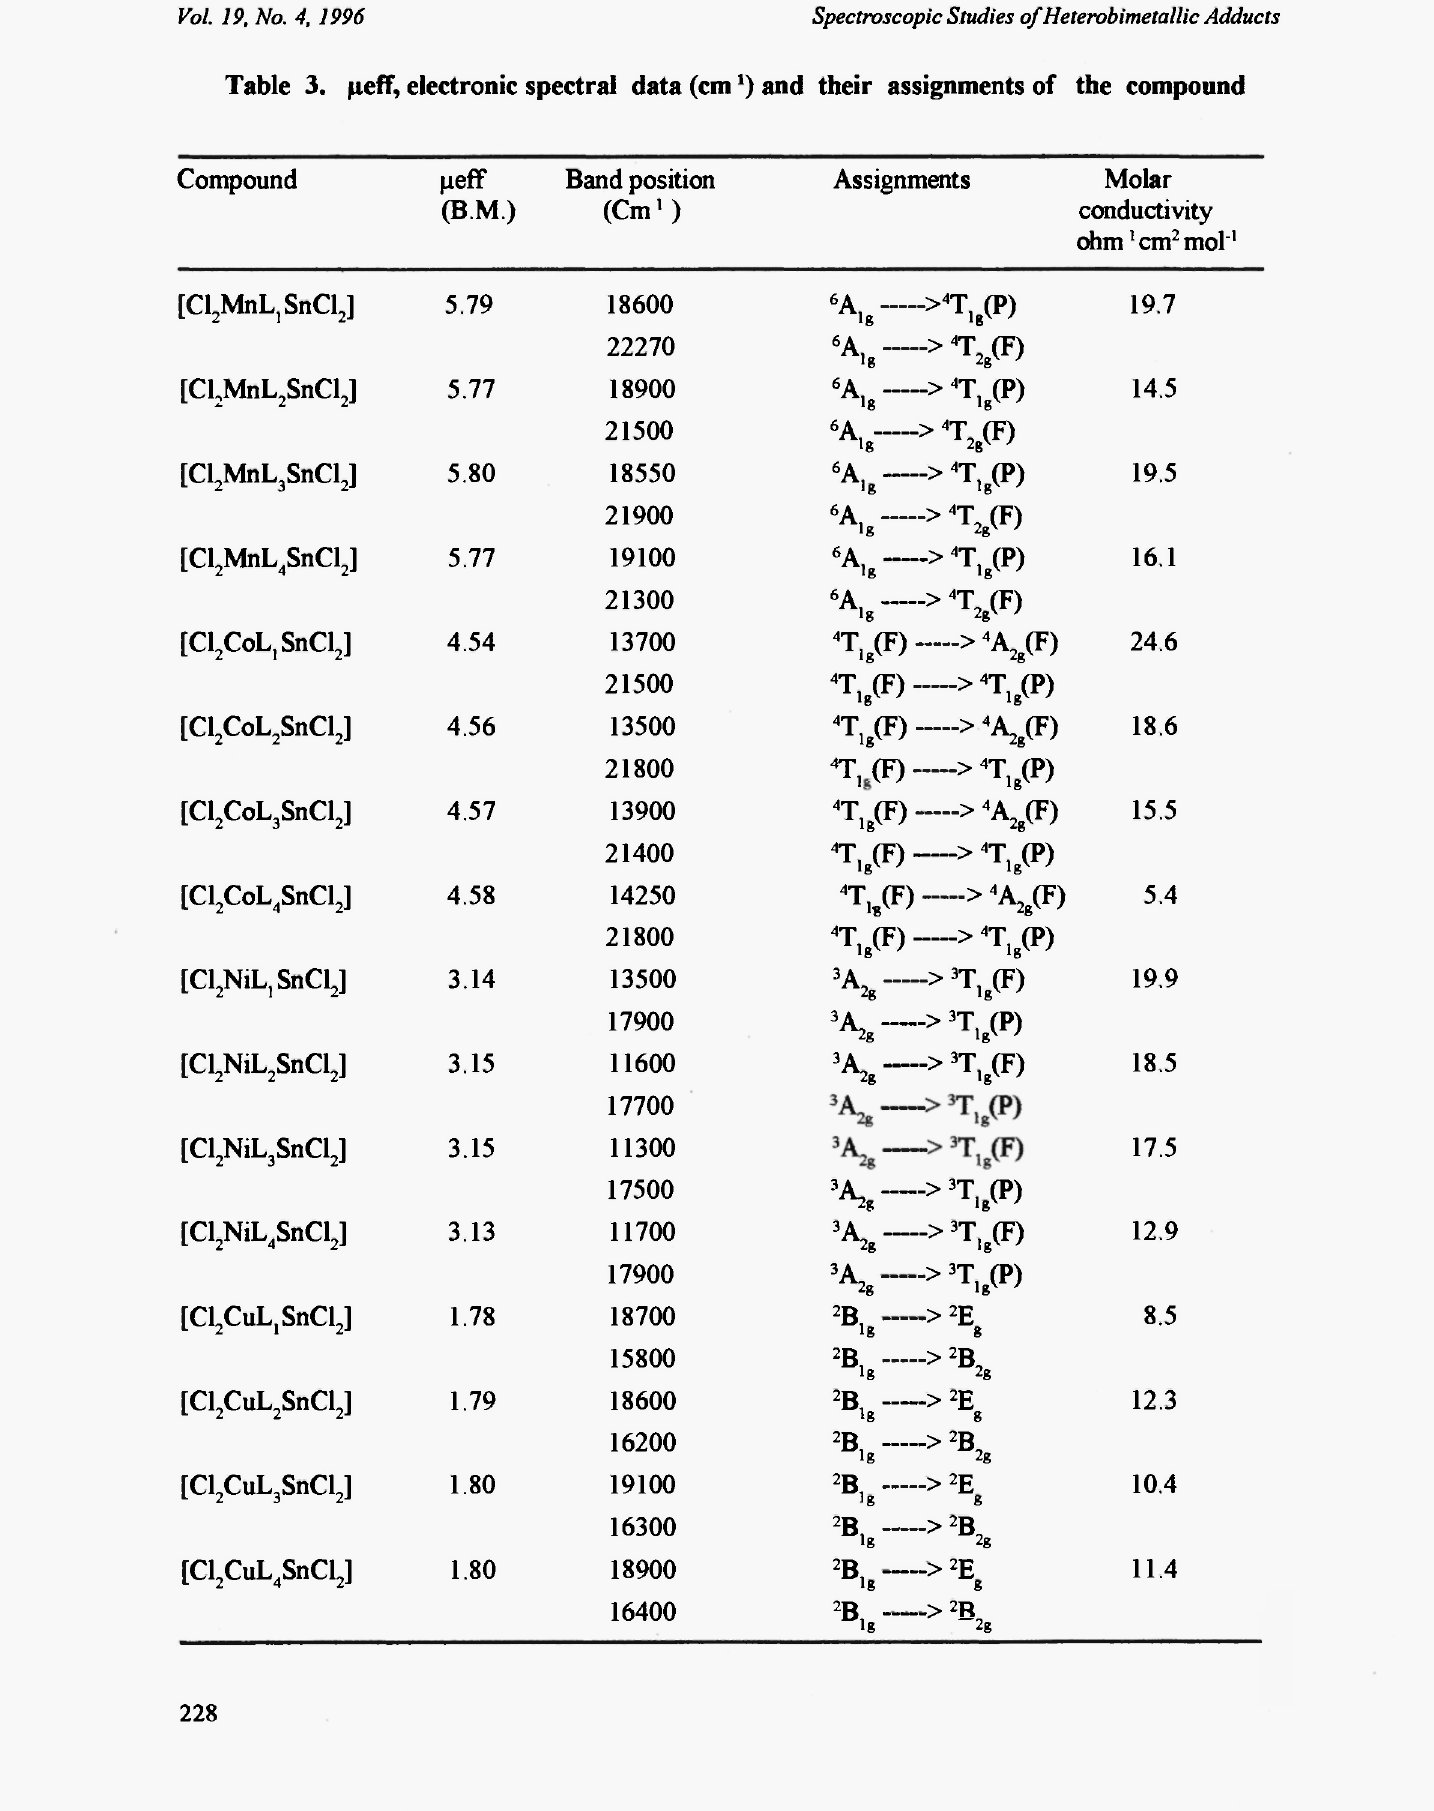
Table 3. μείΤ, electronic spectral data (cm 1 ) and their assignments of the compound